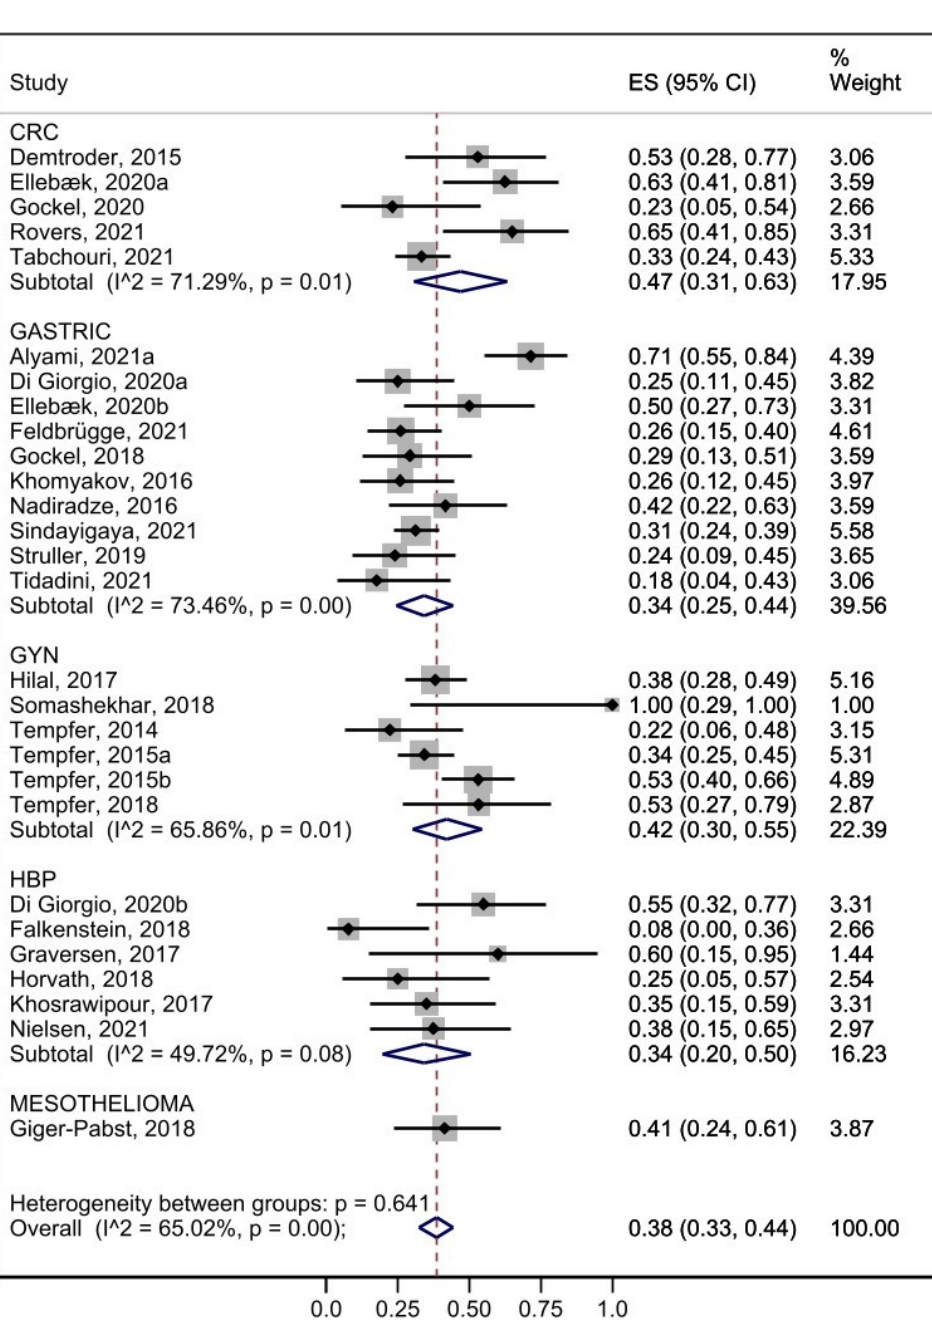
Figure 3. Forest plot of pooled prevalence of PIPAC ≥ 3 stratified by tumor origin [8,10–